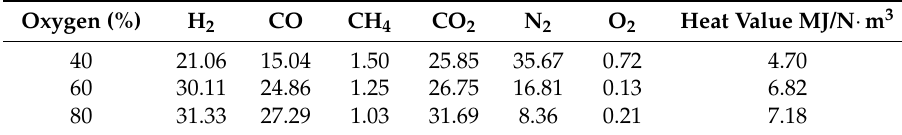
Table 5. Gas composition under oxygen-enriched gasification conditions (V%).